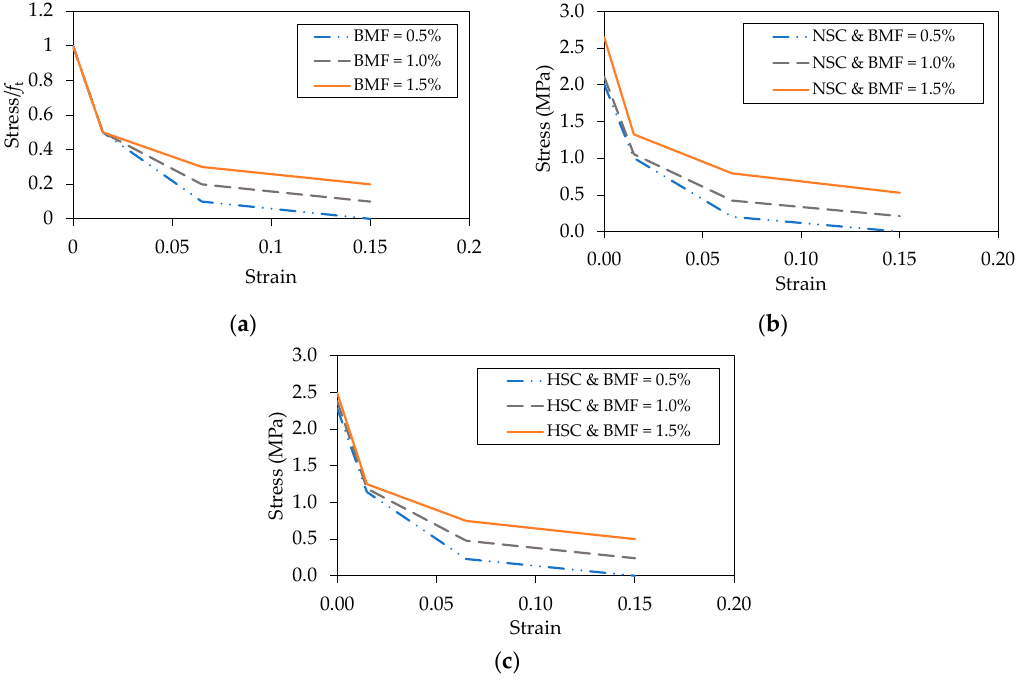
Figure 23. Tensile softening laws obtained from the inverse analysis: ( a ) normalized laws; ( b ) NSC; ( c ) HSC.